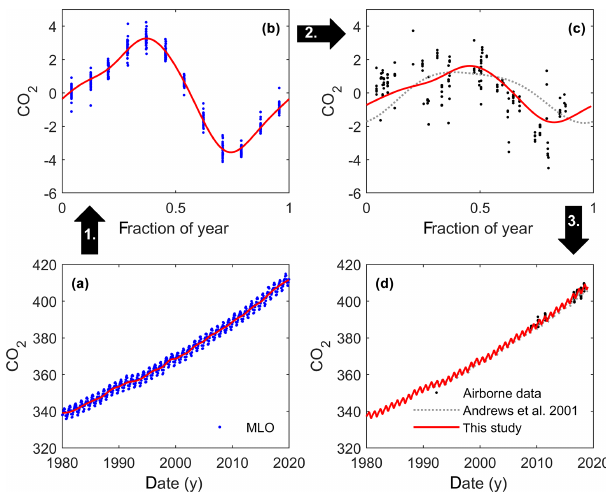
Figure 2. Illustration of the major steps in deriving a tropical up- per tropospheric reference time series. Panel (a) shows the monthly mean surface CO 2 concentrations at Mauna Loa (MLO) (Keel- ing et al., 2001) with a stiff spline trend shown in red. Panel (b) shows a fit of the mean seasonal cycle at MLO compared to de- trended observations from 1980 to 2019. Panel (c) shows the 1- month lagged seasonal cycle (red line) rescaled in amplitude to match detrended airborne observations in the equatorial upper tro- posphere (20 ◦ S < lat < 20 ◦ N, alt > 8km, black). The seasonal cy- cle derived by Andrews et al. (2001) is presented as a dotted grey line for reference. Panel (d) shows the resulting upper tropospheric mean reference time series (TRTS, red) used for CO 2 in the age-of- air algorithm with the airborne observations from the tropical upper troposphere (black dots) and the time series (grey dotted line) of Andrews et al.